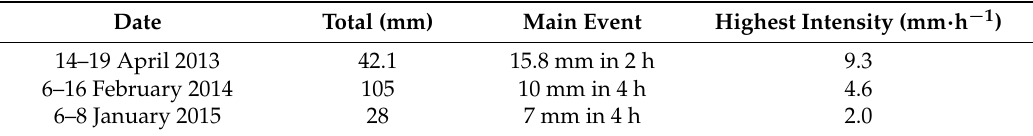
the whole event.